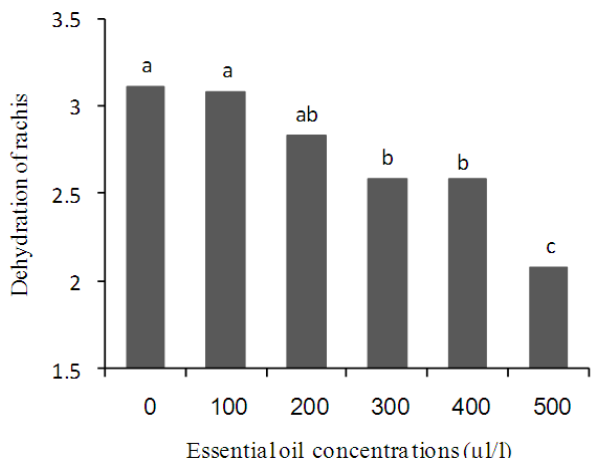
Fig. 7. The effect of essential oil treatment on chroma of ‘Bi- daneh Qermez’ table grape